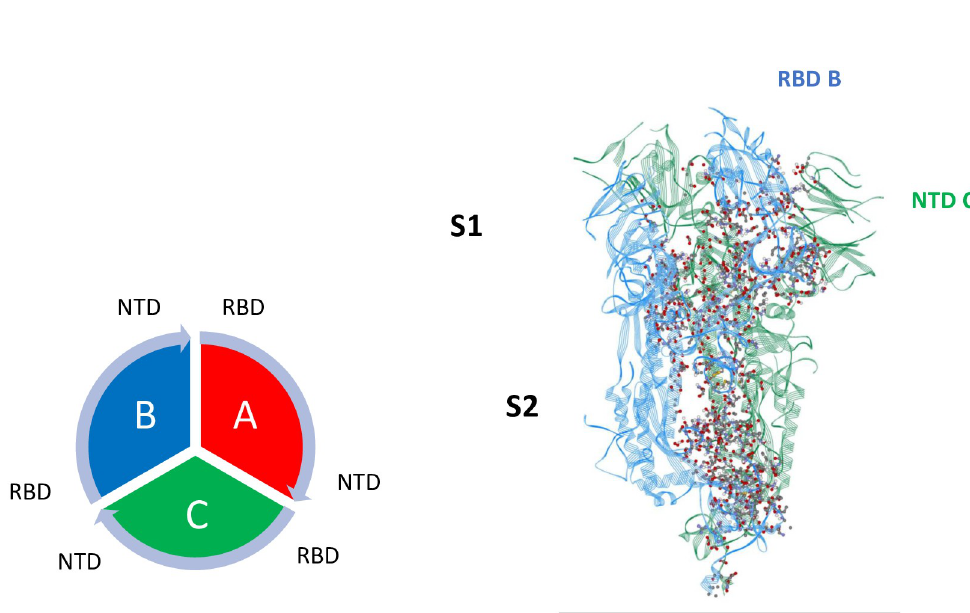
Fig 2. Dominant energy landscape for the interaction of chain B (Down; blue) with chain C (Down; green) for 6VSB. The dominant atom-atom interactions are shown by ball and sticks.